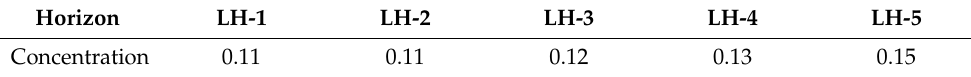
Table 9. Vertical distribution of Mn in the aged tailings of the Kovdorsky GOK, wt.%. Horizon LH-1 LH-2